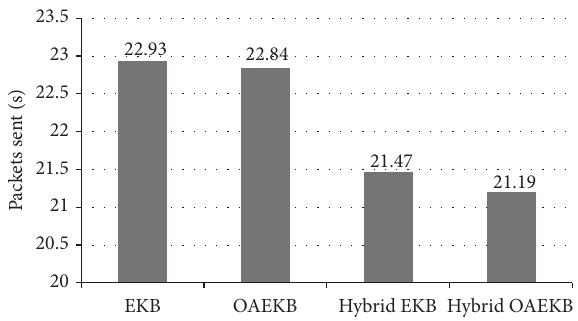
Figure 8: Total hit percentages, EKB at threshold 𝑔 = 45 . Figure 9: Packets per second, EKB at threshold 𝑔 = 45 . Table 5: AEE comparison with high